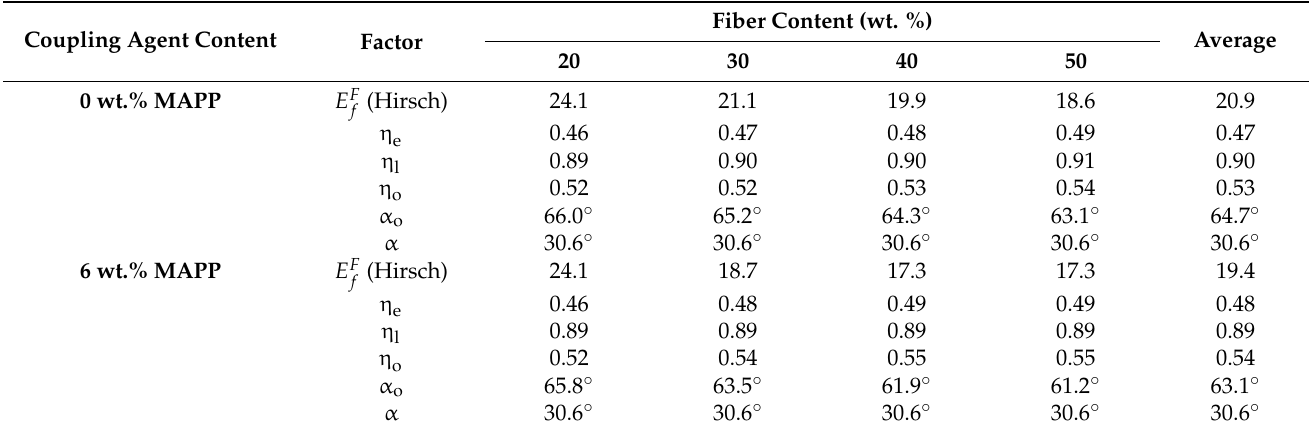
Table 5. Micromechanics of the flexural modulus. Intrinsic flexural strength ( E F factor ( η l ), orientation factor ( η o ), limit angle ( α o ), mean orientation angle ( α ).